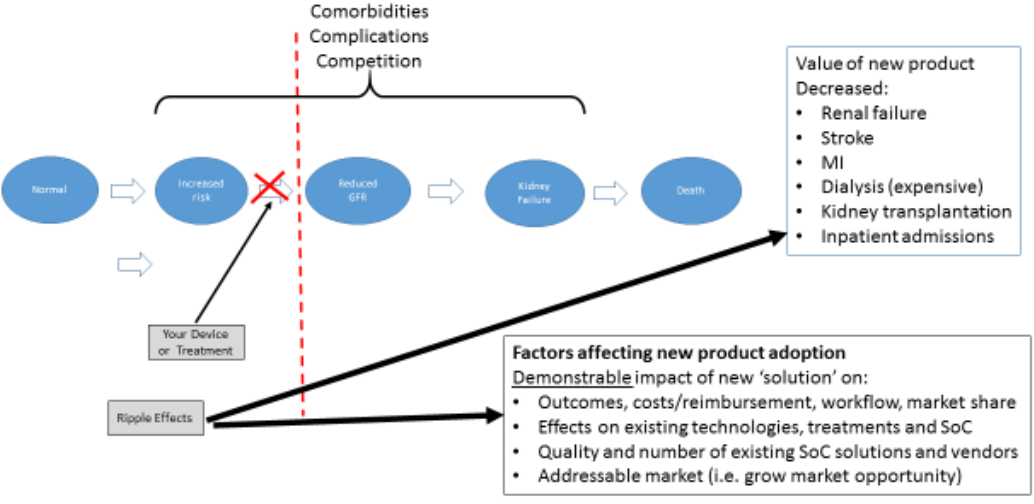
Figure 3. Natural history of disease and nodes for intervention and innovation.